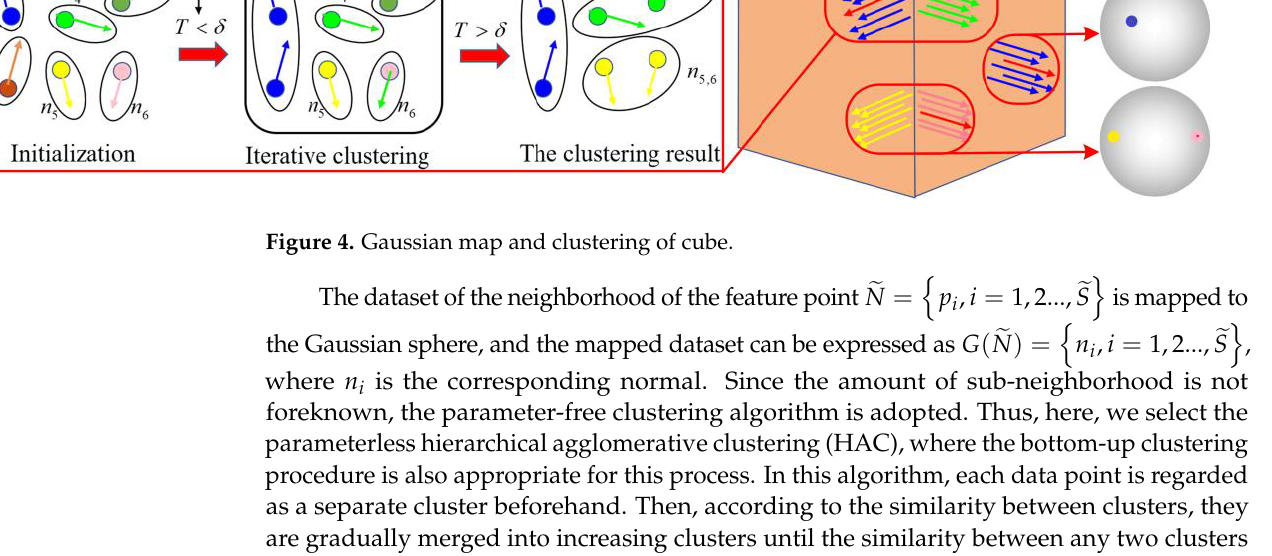
7 of 18 Figure 3. Feature detection results by common method [11] and our method under large-scale noise. Left: smooth-feature model with 0.25% Gaussian noise. Middle: anchor model with 0.30% Gaussian noise. Right: block model with 0.30% Gaussian noise. 5. Robust Normal Estimation In this section, we explain how to reliably estimate the normals of the distinguished feature points via the normal mollification methodology, which divides into two succes- sive steps: a preliminary normal estimation based on neighborhood segmentation and a further normal estimation based on residual under various difficult scenarios. 5.1. Normal Mollification Based on Neighborhood Segmentation Gaussian map and clustering: The Gaussian map of the point cloud is used to map the normals of the surface in Euclidean space to the unit sphere. Based on the fact that the normals of points change continuously in the smooth regions but alter dramatically when located at the sharp surface, the normals of smooth areas will form a single cluster, while those near the sharp feature will form multiple clusters on the Gaussian sphere and each cluster corresponds to different surfaces, as shown in Figure 4. Since the fitting-based ap- proaches generally assume that the surface is smooth everywhere and the estimated nor-